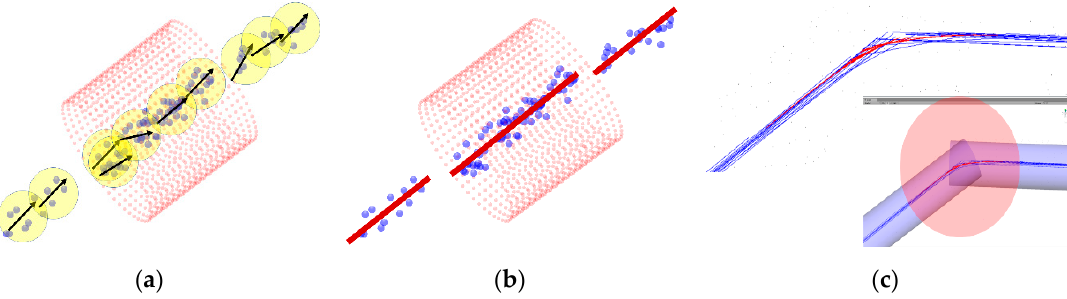
Figure 6. Searching method for center axis estimation: ( a ) eigenvector at a point; ( b ) sum of the eigenvectors; ( c ) matching cylinder result through vector summation.